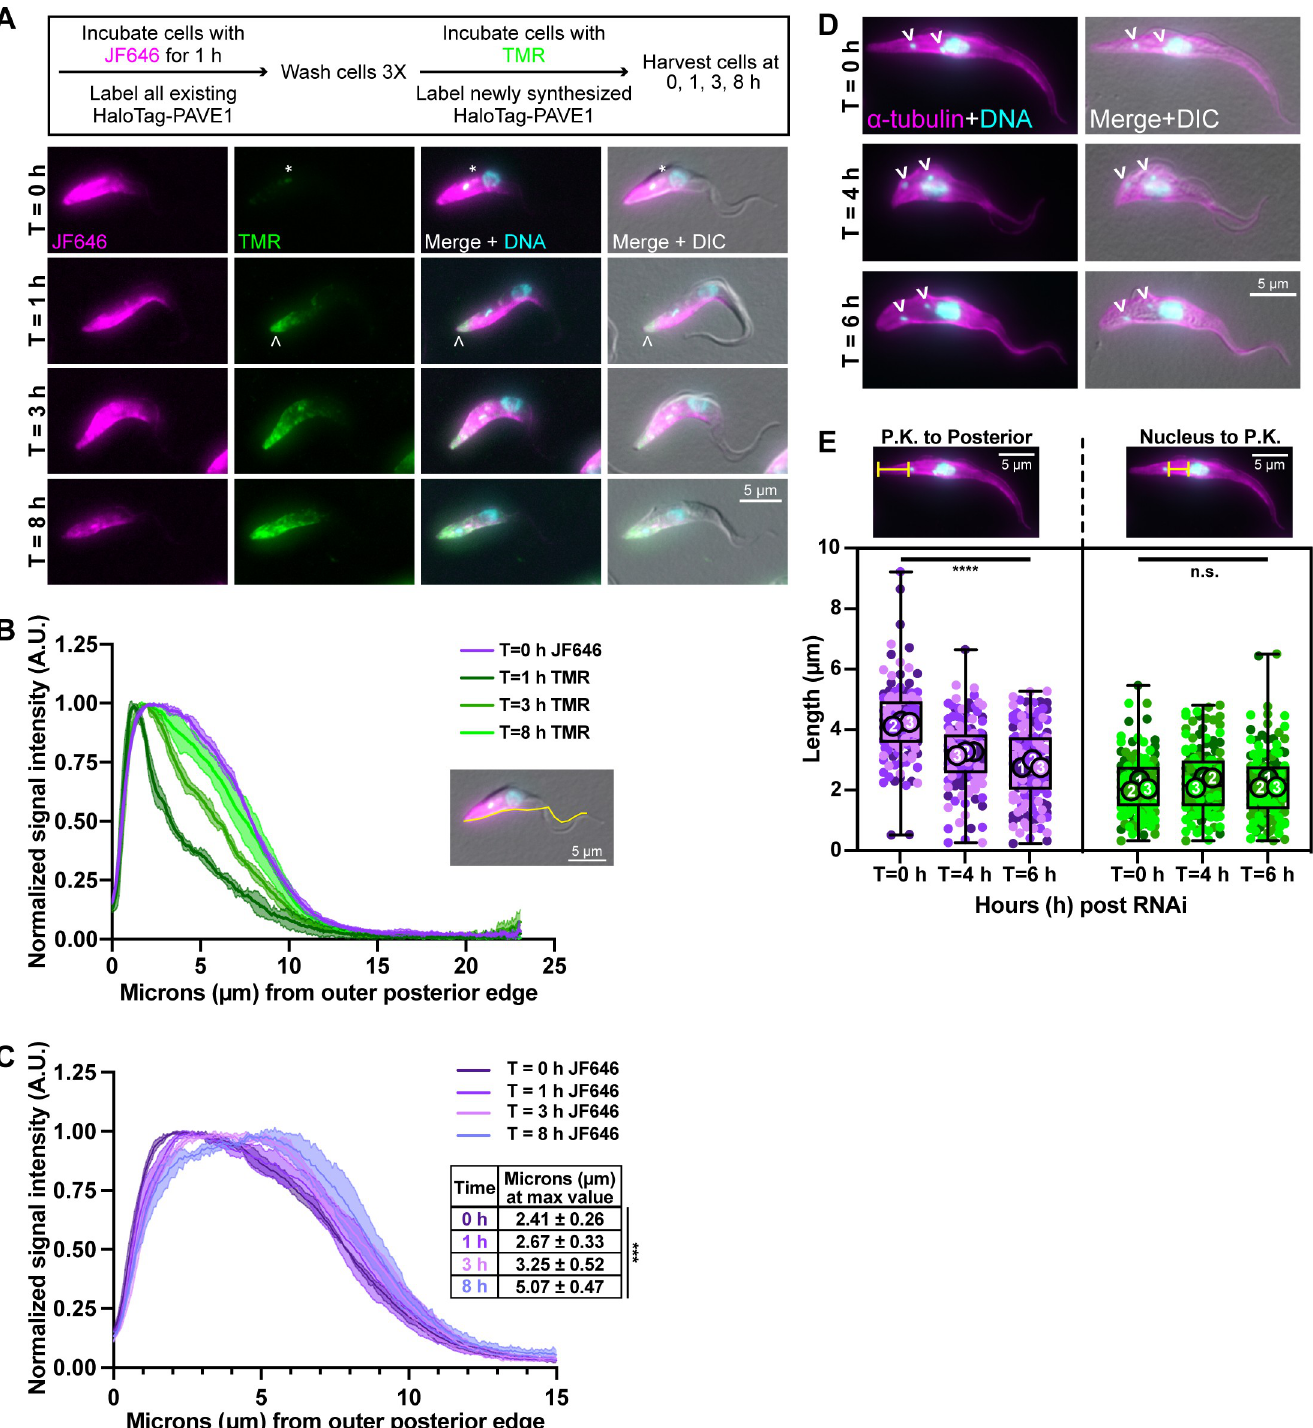
Fig 3. PAVE1 is added to and stabilizes the microtubules at the extreme posterior end of the array. (A) HaloTag-PAVE1 cells were fixed in paraformaldehyde at T = 0 h, T = 1 h, T = 3 h, and T = 8 h after the addition of TMR-conjugated HaloTag ligand to cell culture in the capping assay. Asterisk represents background labeling of the endomembrane system. Empty arrowhead is pointing to the earliest addition of HaloTag-PAVE1, represented by TMR labeling, at the extreme cell posterior. (B) Fluorescence intensity quantification of HaloTag ligand labeling along the ventral edge of the cell body at T = 0 h, T = 1 h, T = 3 h, and T = 8 h after TMR substrate addition. Fluorescence intensity was normalized to 1 at each time point in order to illustrate the shape of the curve. 50 1N1K cells at each time point from N = 3 independent biological replicates were measured. (C) Fluorescence intensity quantification of JF646-HaloTag ligand labeling as in (B). Inset displays the distance